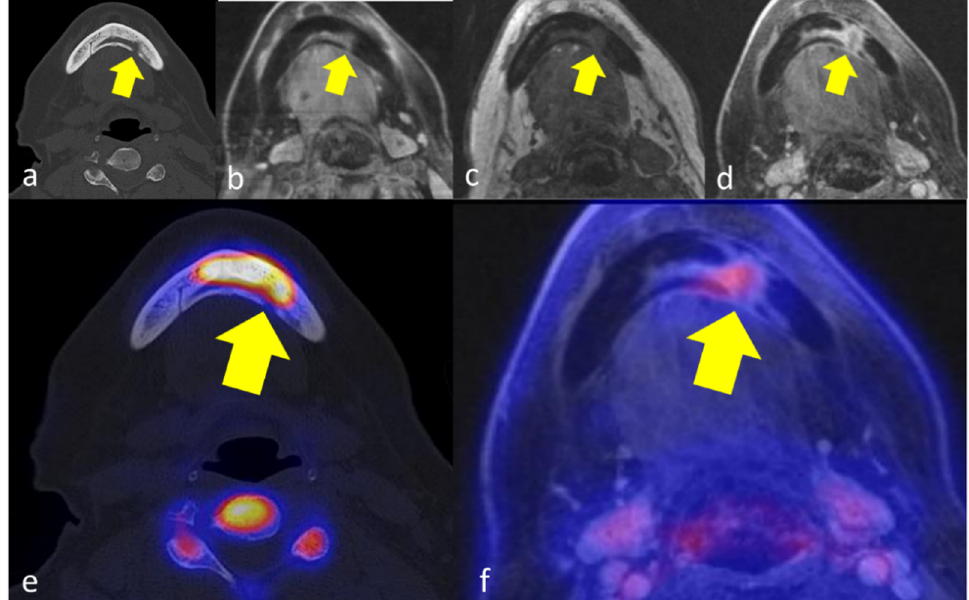
Figure 1. 66 years old female patient with secondary chronic OMJ in region 33–35 of the mandible (yellow arrows), showing a diffuse trabecular sclerosis in CT with focal cortical erosion ( a ), corresponding edema in T2-weighted images ( b ), and T1-weighted images ( c ) and increased gadolinium enhance- ment ( d ). [18F]fluoride-PET/CT reveals markedly increased tracer uptake in the affected jawbone below the extent of sclerosis ( e ) and moderately increased tracer uptake in [18F]FDG-PET/MRI ( f